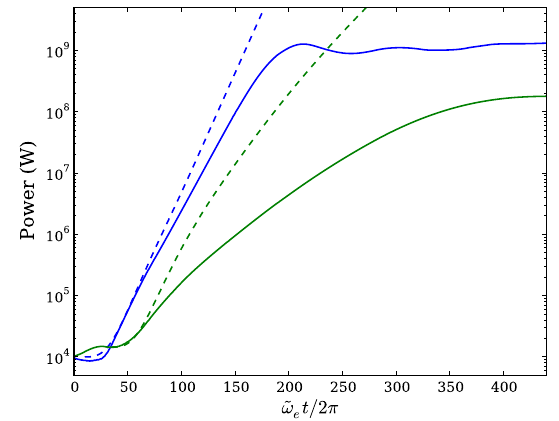
FIG. 5. Steady-state simulations. Radiation power as a function of time for the one-dimensional (blue lines) and three- dimensional (green lines) cases modeled by PLARES (solid lines) and with help of ad hoc iterative model (21) (dashed